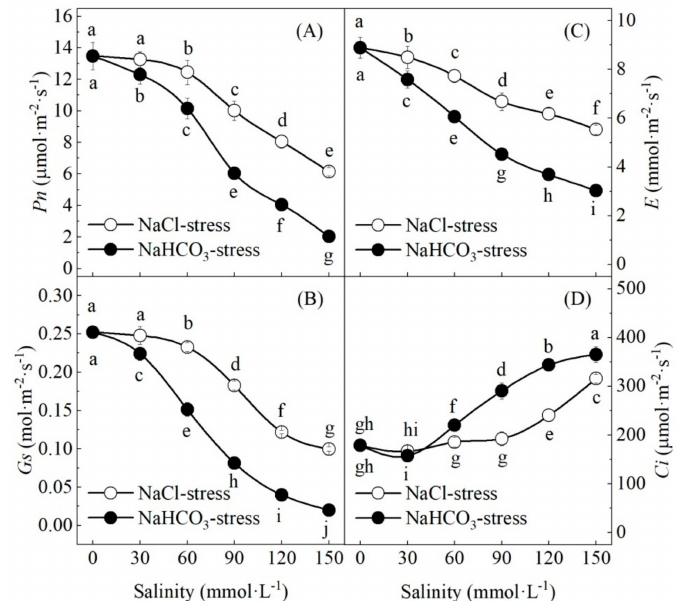
Figure 3. E ff ects of NaCl and NaHCO 3 stresses on the net photosynthetic rate ( A ), stomatal conductance ( B ), transpiration rate ( C ), and intercellular CO 2 concentration ( D ) of common bean ( Phaseolus vulgaris ) seedlings. Common beans were treated with NaCl (30–150 mmol · L − 1 , pH 6.65–6.86) and NaHCO 3 (30–150 mmol · L − 1 , pH 8.17–8.27) stresses. Data points and bars represent the mean ± SD of three